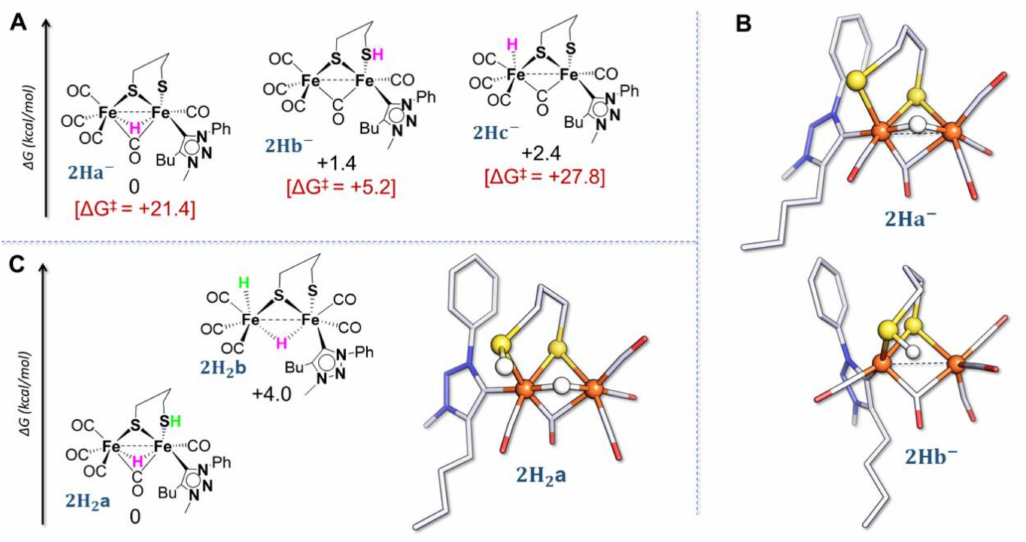
Figure 6. ( A ) thermodynamic speciation of 2H − . Furthermore, the activation barrier associated with the formation of each protonated form are reported (red values). ( B ) optimized structure of thermodynamic ( 2Ha − ) and kinetic ( 2Hb − ) products of the first protonation. ( C ) thermodynamic speciation of 2H 2 and optimized structure of 2Ha 2 . Atom coloring: Fe = orange, S = yellow, C = grey, N = blue, and O = red. H atoms are omitted for clarity. For simplification, net charges on structures are not